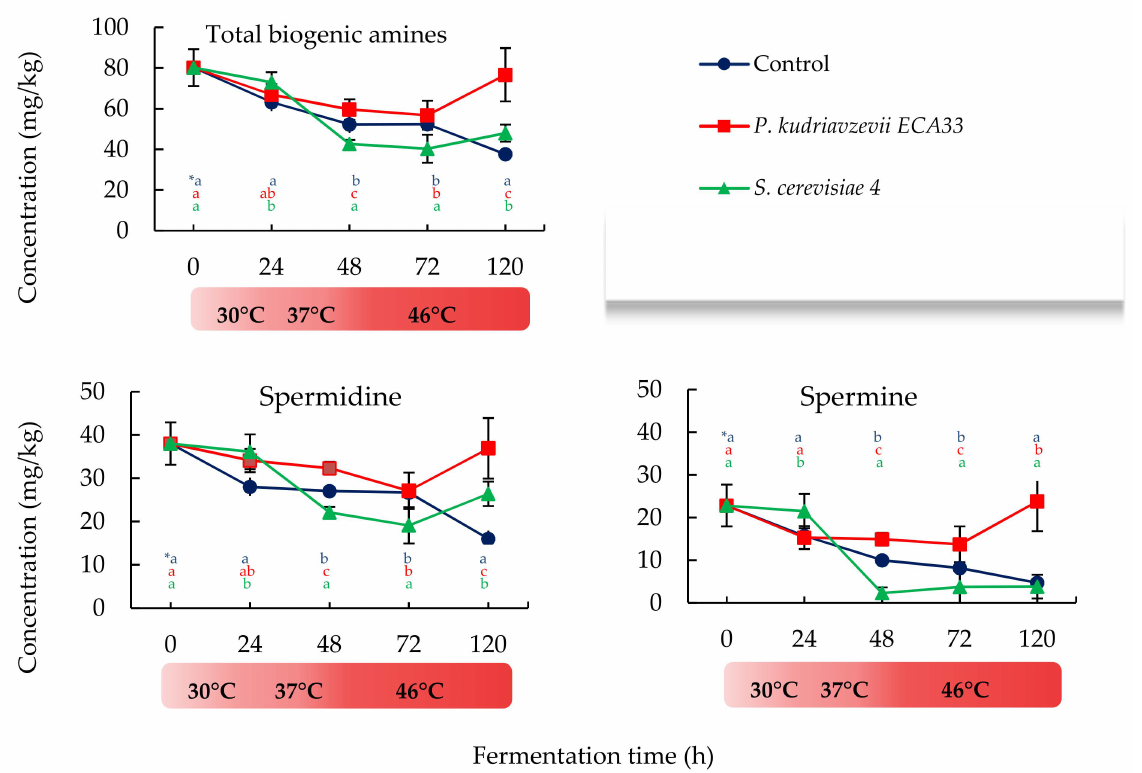
Figure 2. Trends of total biogenic amines, spermidine and spermine in the batches inoculated with P. kudriavzevii ECA33 (red line), with S. cerevisiae 4 (green line), and in uninoculated control (blue line). Data are expressed as mean ± standard deviation (SD) values from duplicate determinations. * Different letters in the same column (hour) indicate significant differ- ences ( p < 0.05) among inoculated strains; first row control, second row P. kudriavzevii ECA33, and third row S. cerevisiae